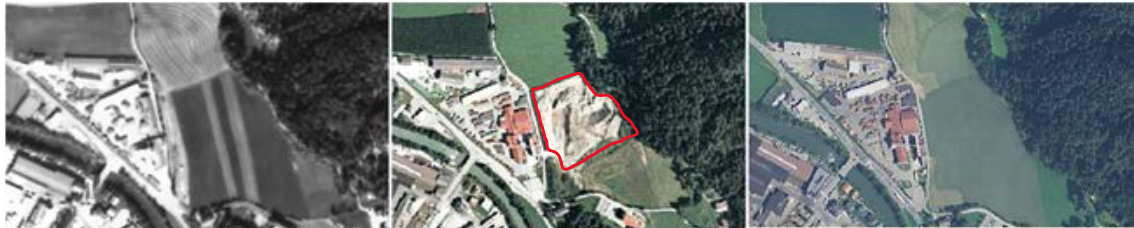
Figure 7. Patches from orthoimages (from left to right: 1986, 1995, 2006) depicting a portion of the territory of Kiens/Chienes in correspondence of polygon ID= 223 (in red on the central patch), where a covered former open pit has been